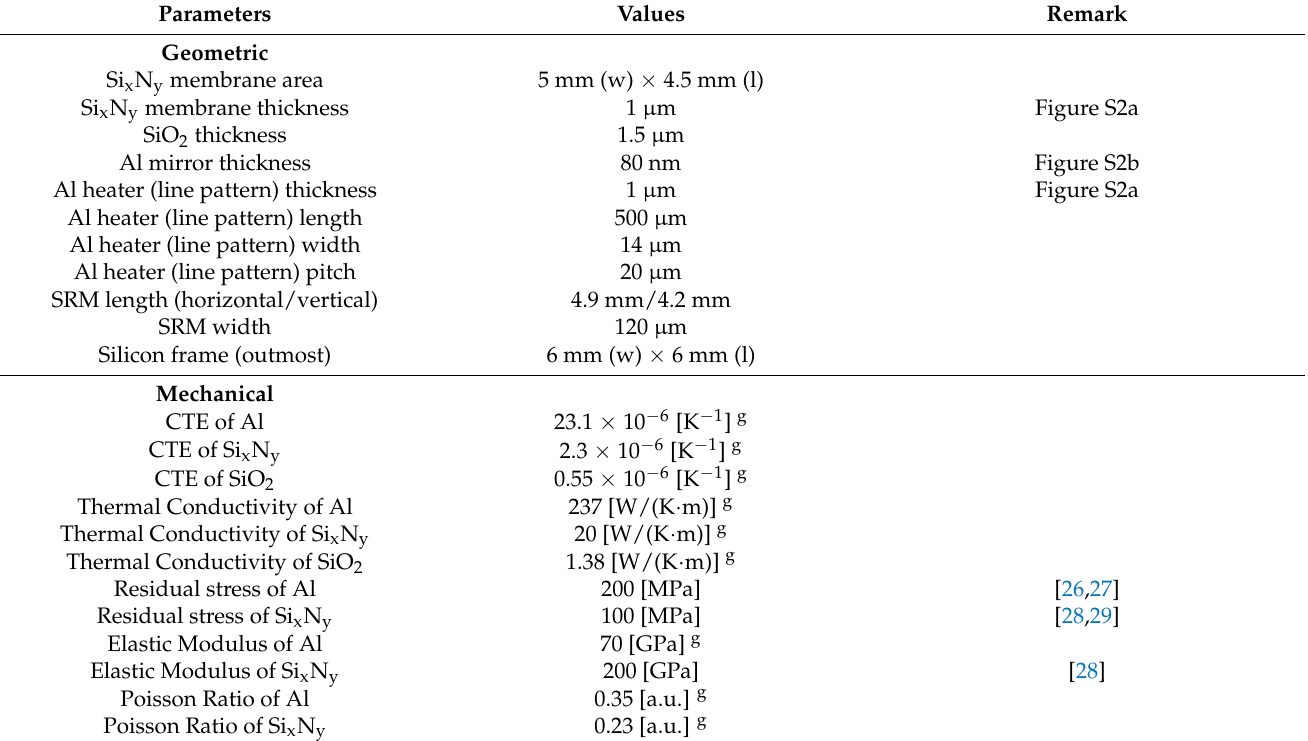
Figure 1. ( a ) Schematic of a silicon micro ( µ ) rim-loaded MEMS mirror (SRM-mirror), consisting of aluminum (Al) thin mirror, silicon nitride membrane, bimorph structures, and the silicon micro rim; ( b ) Numerical analysis on film flatness of SRM-mirror depending on the rim, by using finite element method (FEM) simulation; ( c ) The cross-sectional profiles (i.e., A-A ′ , B-B ′ in ( b )) of the thin mirror membrane with/without the SRM, and the calculated curvature ( κ ) and radii of curvature (R). Table 1. Geometric and mechanical parameters of the SRM-mirror.